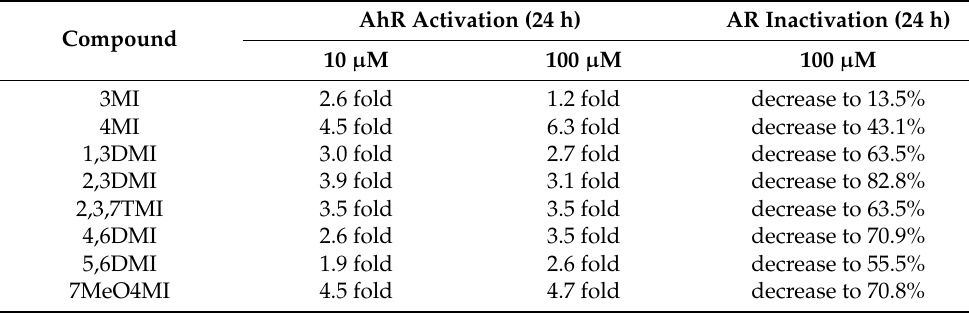
Figure 2. AR transcription activity after indoles treatment. AIZ-AR cells were incubated for 24 h with indoles and controls in the absence ( A ) or presence of 10 nM DHT ( B ). The transcription activity of AR was evaluated using RGA. In agonist mode ( A ), the data obtained are expressed as fold inductions to UT. In antagonist mode ( B ), the results are expressed as a percentage, when DHT 10 nM is set to 100%. * represents a significant difference ( p < 0.05) between untreated (UT) and compound-treated cells. Table 1. Compounds selected for further experiments based on RGA results.